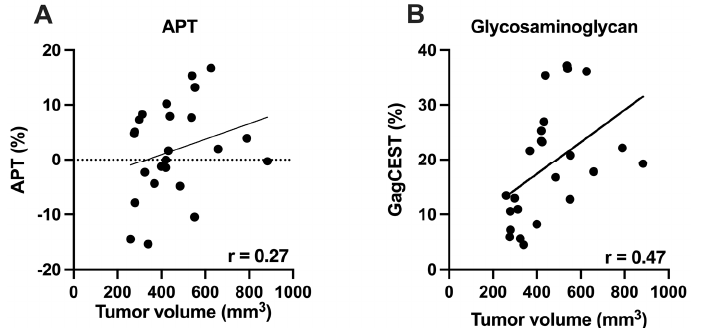
Figure 3. Relationship between Tumor volume and CEST parameters in the advanced stages of PDAC. ( A ) showing relationship between Tumor volume and Amide proton transfer (APT%); ( B ) showing relationship between Tumor Volume and Glycosaminoglycans (GagCEST).